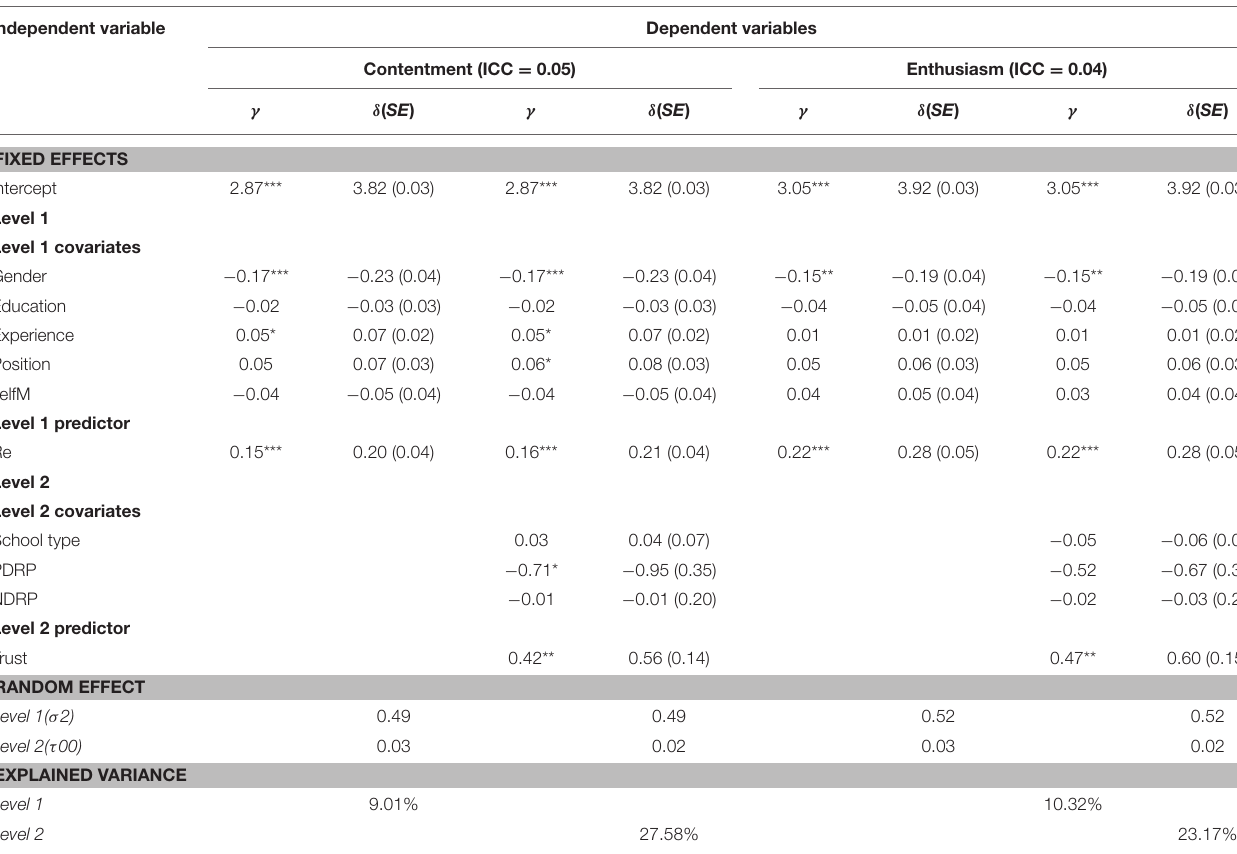
TABLE 3 | Multilevel estimates for models predicting contentment and